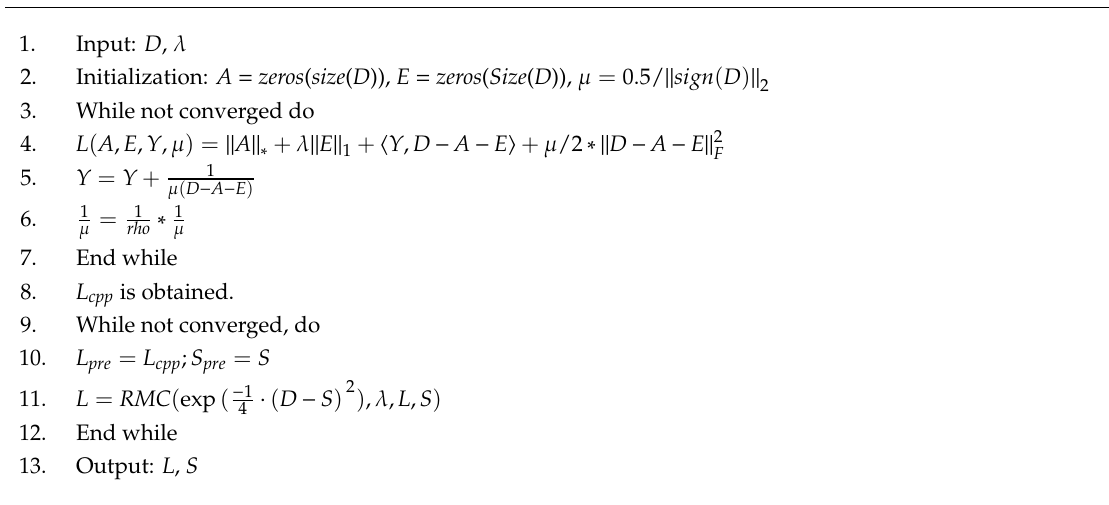
Algorithm 1 SRPCP to NOP Model